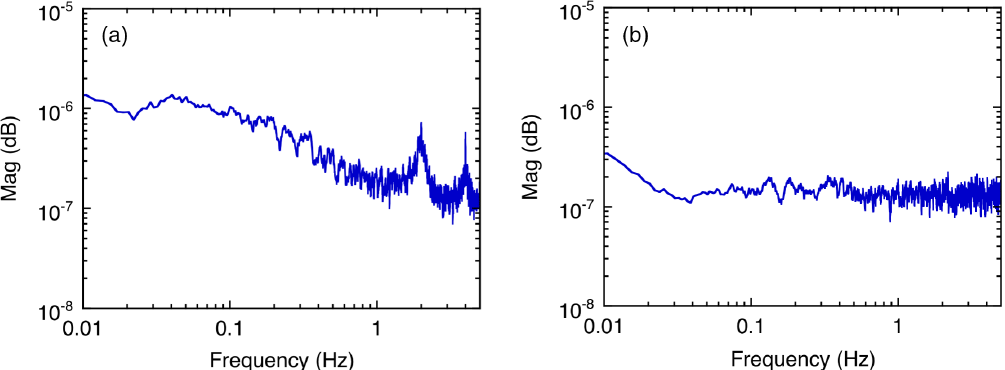
FIG. 15. Spectral analysis results for the vertical beam position after BC1. (a) The frequency of the beam position jitter was observed to be 2 Hz before the modification. (b) The peak at 2 Hz was removed after the